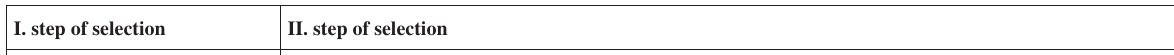
Table 1. Plant material of the selection